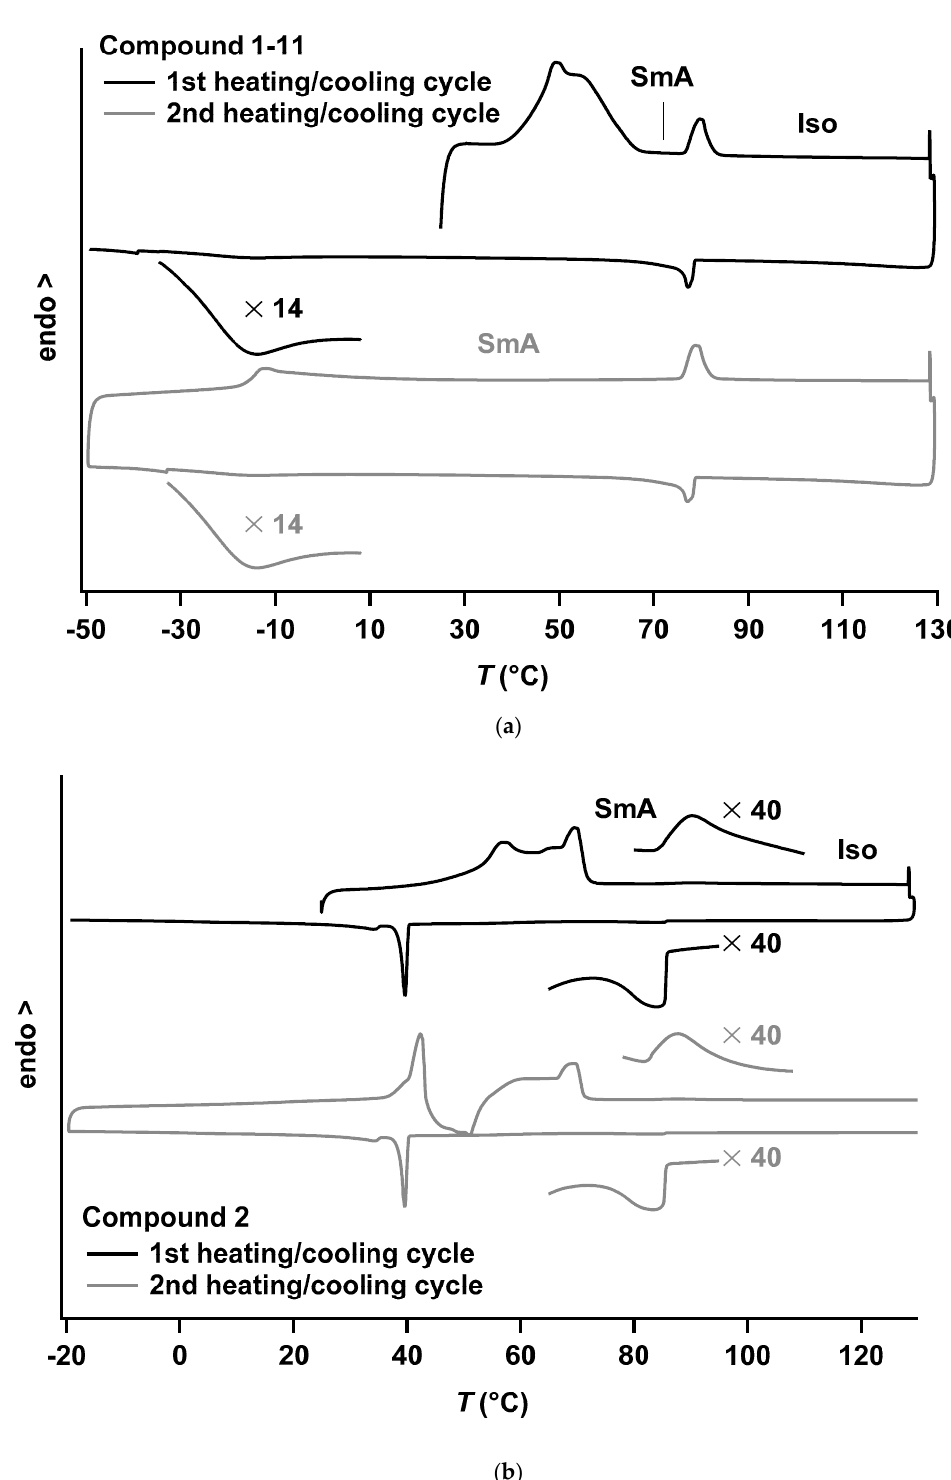
Figure 2. Differential scanning calorimetry (DSC) data recorded for ( a ) 1-11 and ( b ) 2 at a heating rate of 10 °C·min − 1 and a cooling rate of 5 °C min − 1 under an atmosphere of N 2 . Endothermic peaks point upward.